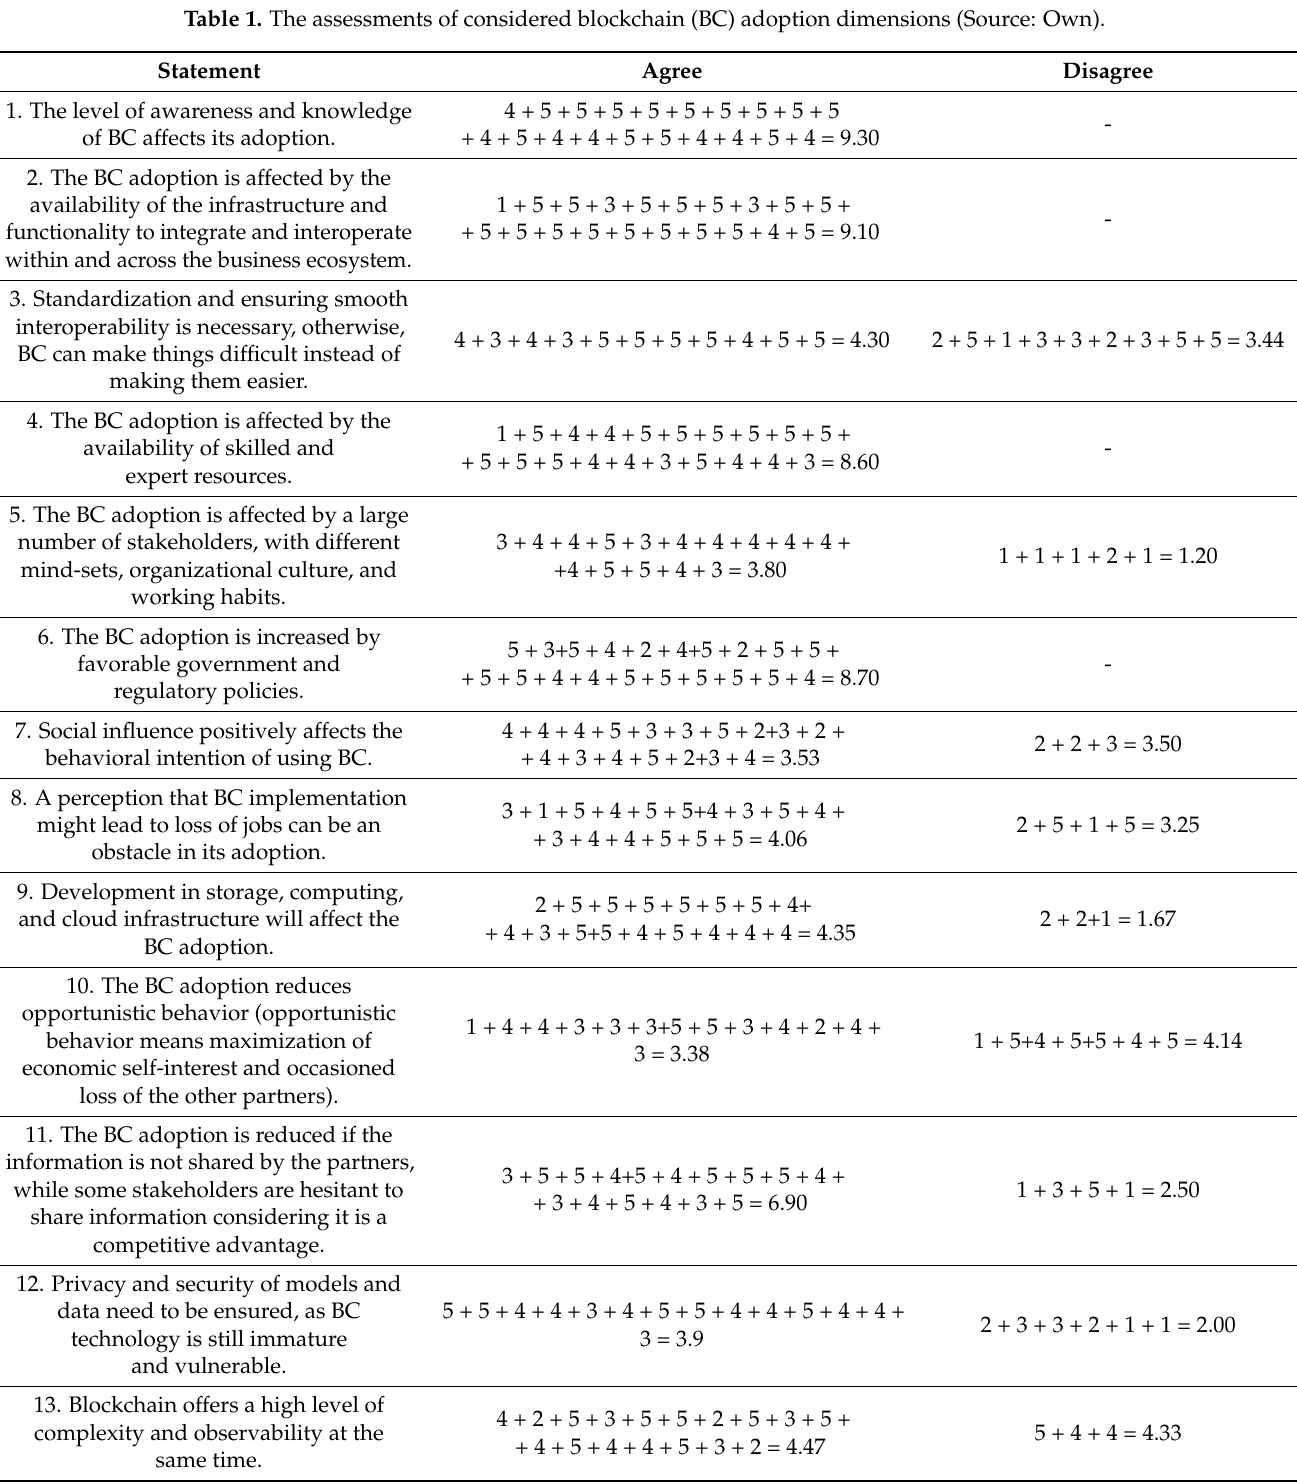
Table 1. The assessments of considered blockchain (BC) adoption dimensions (Source: